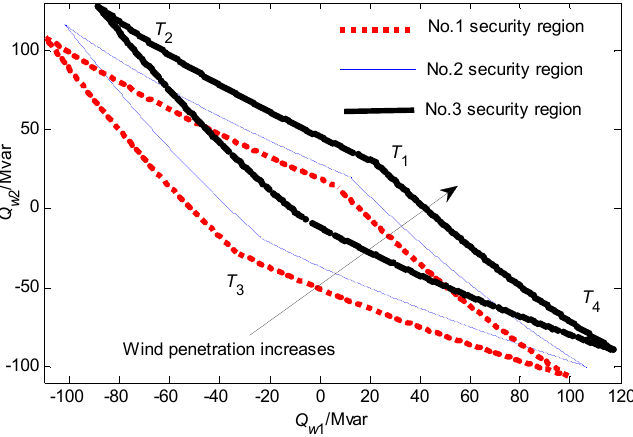
for different wind penetration S